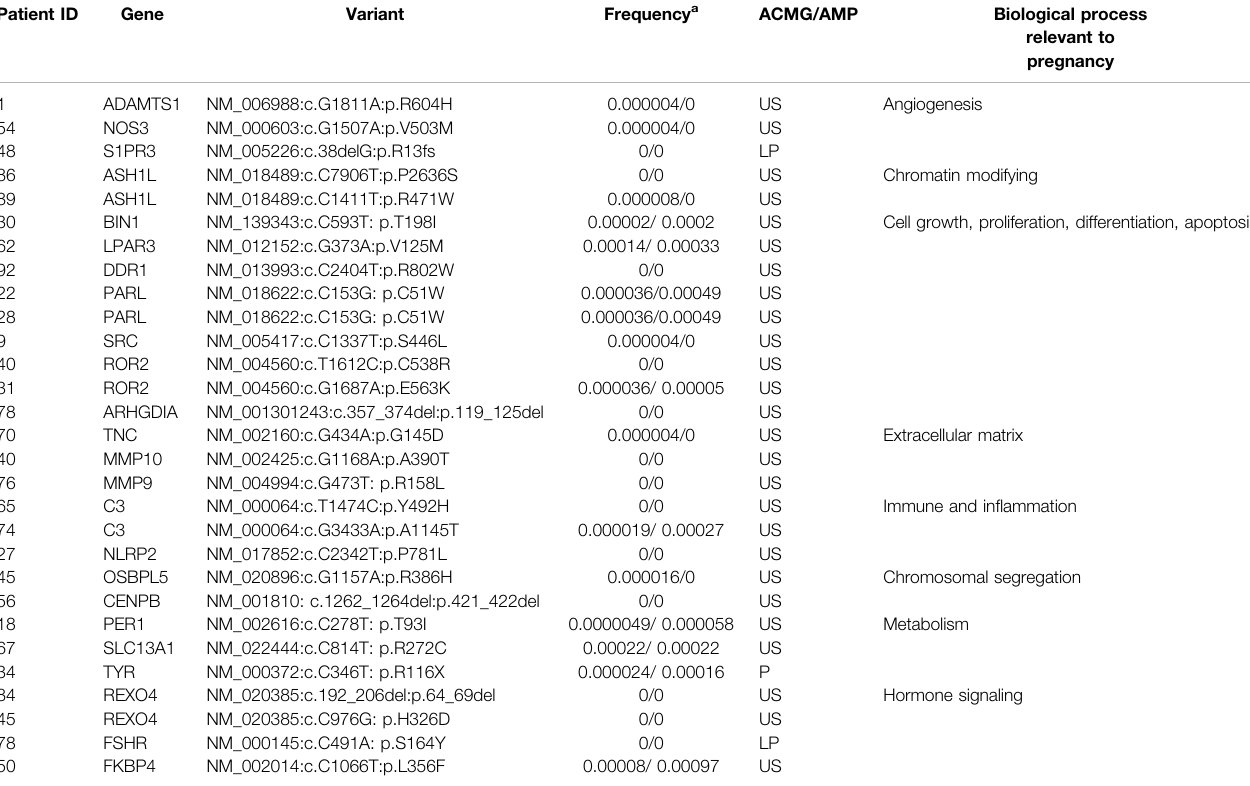
TABLE 2 | The other heterozygous candidate variants identi fi ed by whole-exome sequencing in patients with recurrent pregnancy loss. Patient